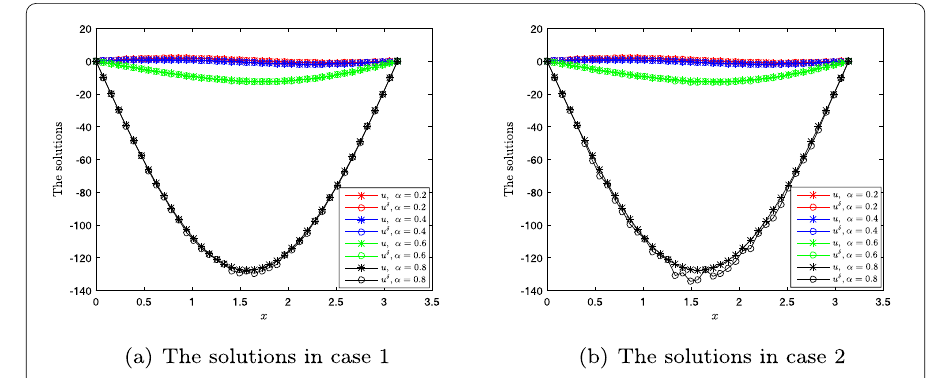
Figure 4 A comparison between the exact and regularized solutions of the proposed method (case 1) and according to [19] (case 2) at t = 0.1 for α ∈ { 0.2;0.4;0.6;0.8 } , δ = 0.001, and N x = N t = 40